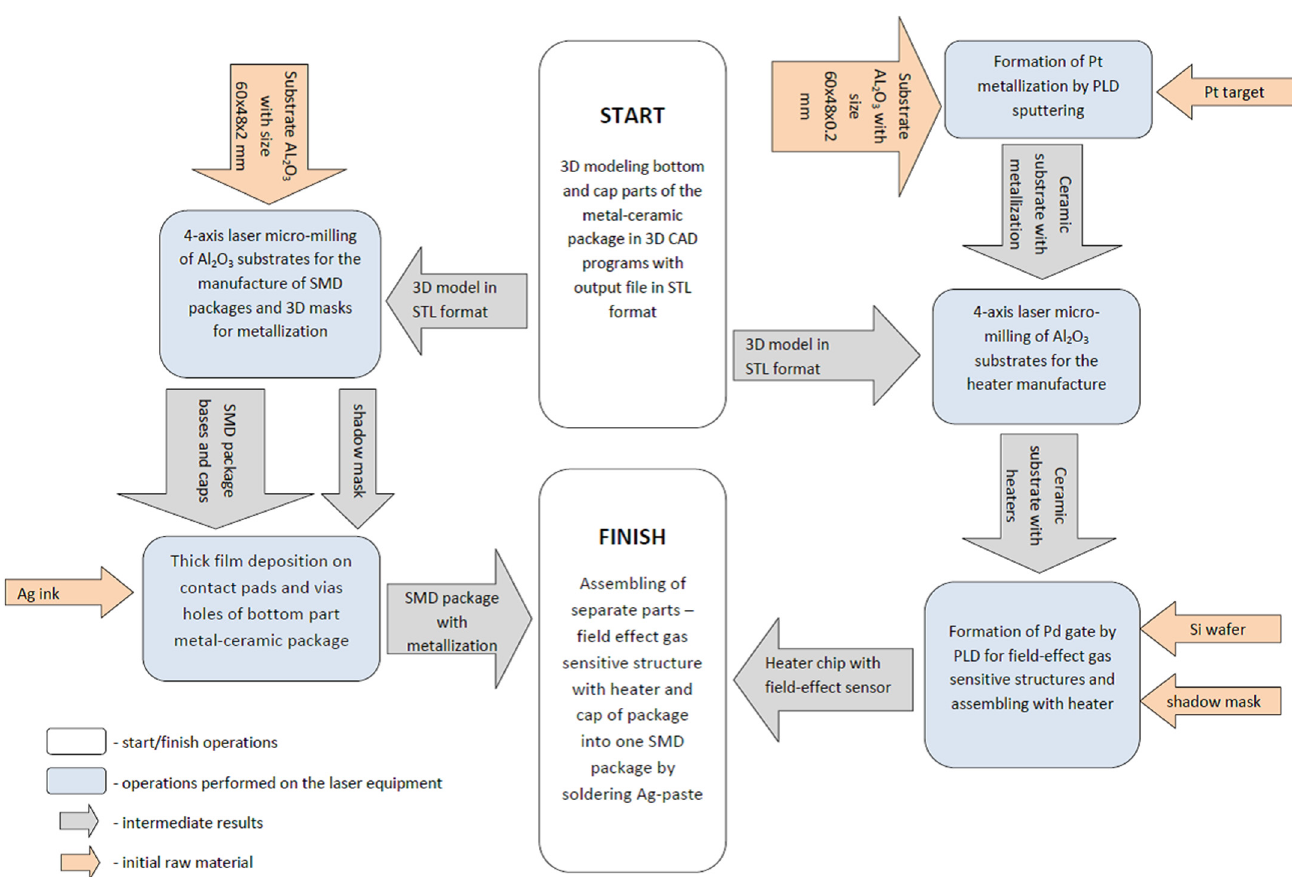
Figure 2. Chart of the technological process steps for the rapid prototyping of a field-effect gas sensor in a metal–ceramic